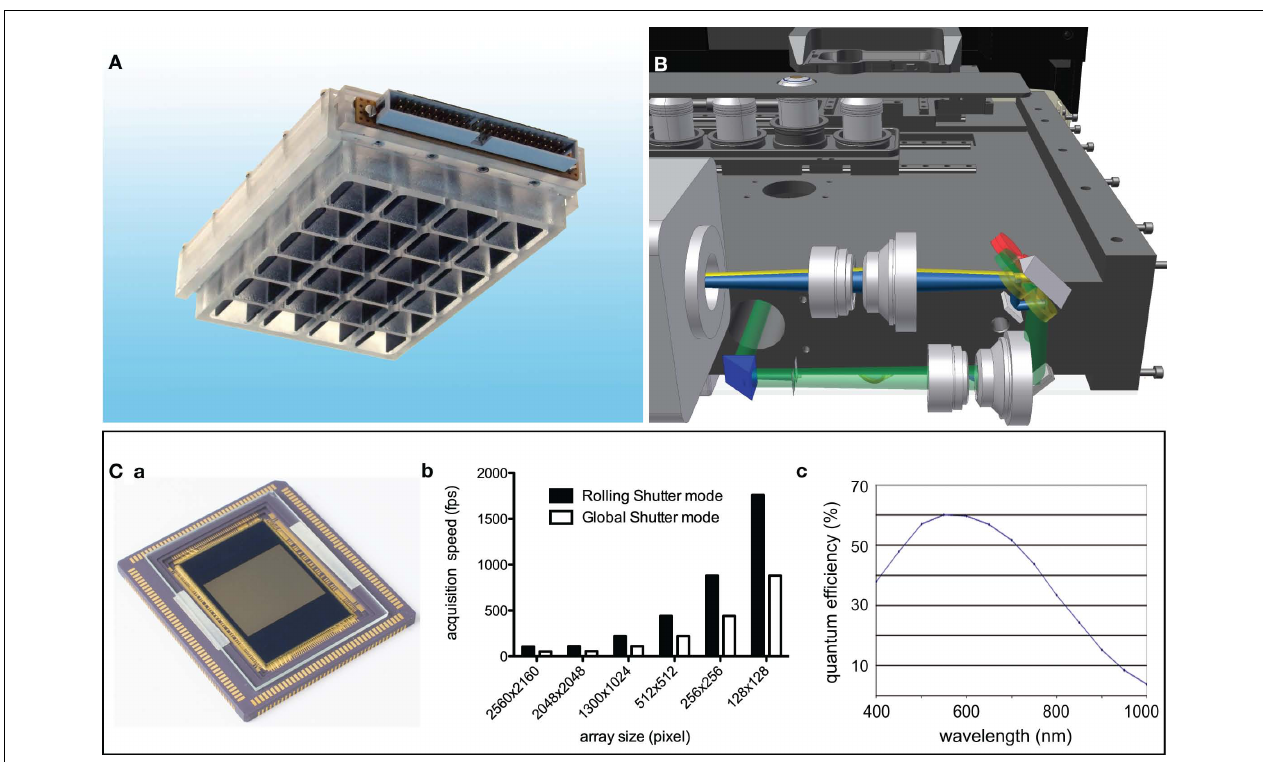
plates and be able to detect two emission channels simultaneously on array detectors like CCD or CMOS based cameras. (B) Is a courtesy from Prof. Rainer Uhl (TILL I.D. GmbH, Gräfelfing, Germany). (C) Shows the state of the art scientific CMOS sensor (a) and key specifications of that sensor, what are frame rates in the range of 1kHz (b) and a quantum efficiency of 60% around 550nm (c) . (D) Is modified from Coates et al.